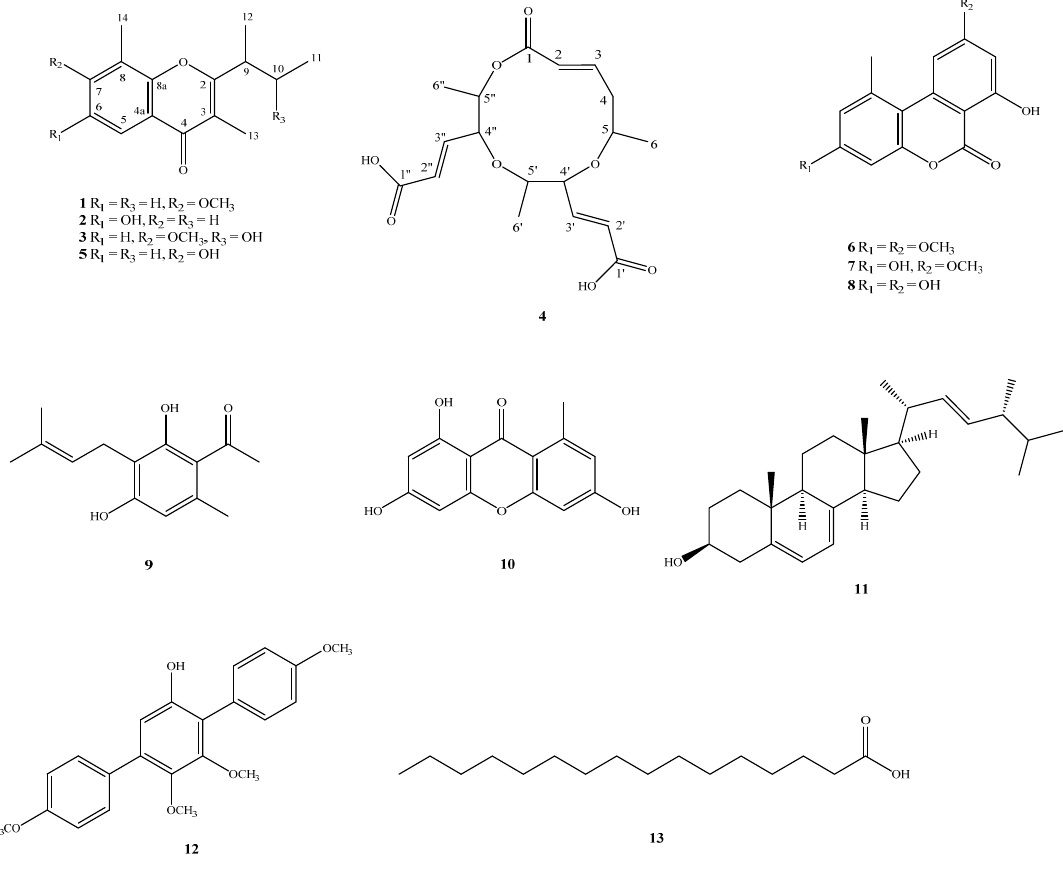
Figure 1. Chemical structures of compounds 1 – 13 .